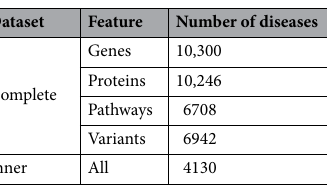
Table 5. Number of diseases in each of the considered